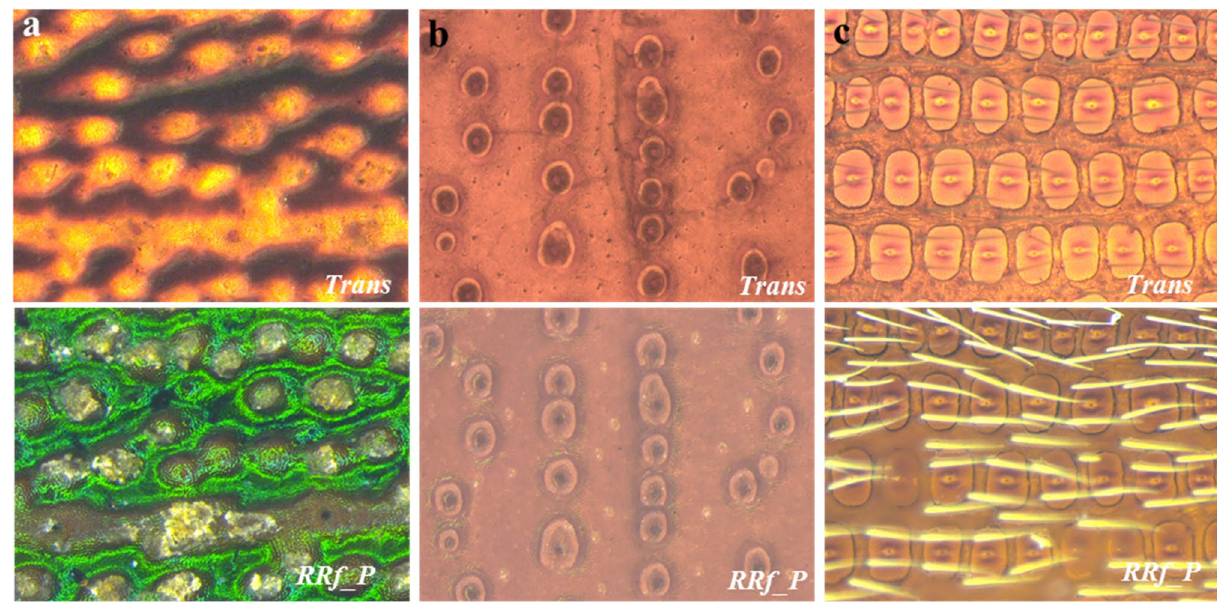
Figure 7. Control study to evaluate imaging capability when using Trans at 100x magnification, which was employed to image (a) Rainbow Scrap Beetle ( Phanaeus vindex ); (b) Black Dung Beetle ( Onitis aygulus ) and (c) Click Beetle ( Orthostethus infuscatus ), which possess some of the thickest and darkest known elytra in beetles. For comparison, the bottom row imaged using the RRf_P system, shows colored pigmentation, waxy coating and excessive setae. The top row represents images captured using the Trans system showing only the cytoskeletal structure, and which remain mostly unaffected by nonuniform surface features.